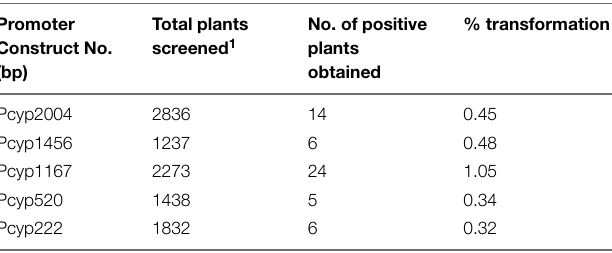
TABLE 2 | Transformation efficiency of Arabidopsis plants using floral dip method. Promoter Construct No.